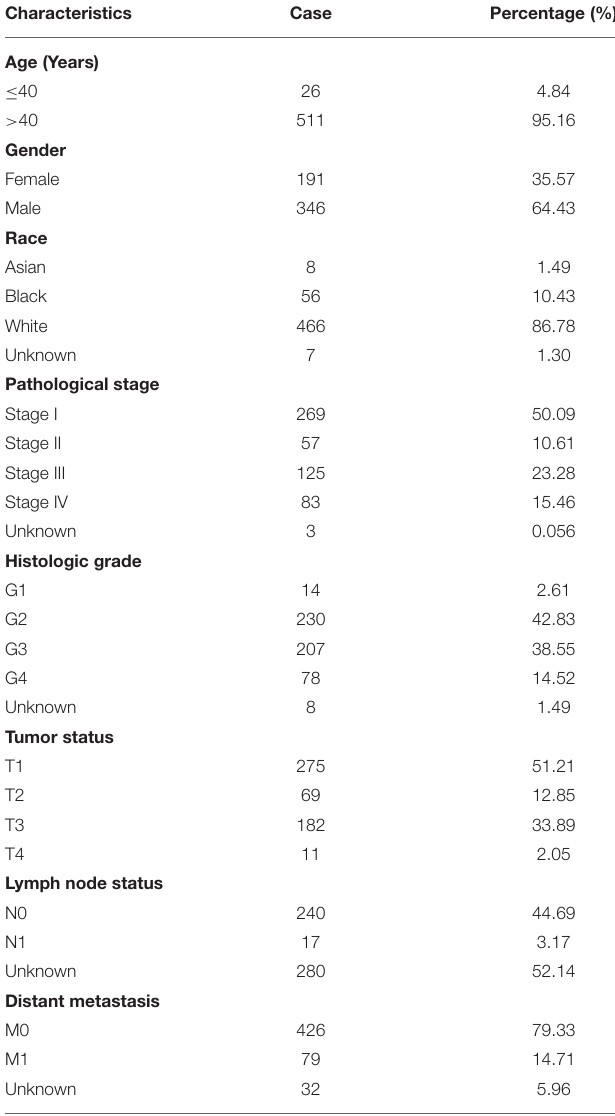
TABLE 1 | Summary of the clinical characteristics in ccRCC patients.